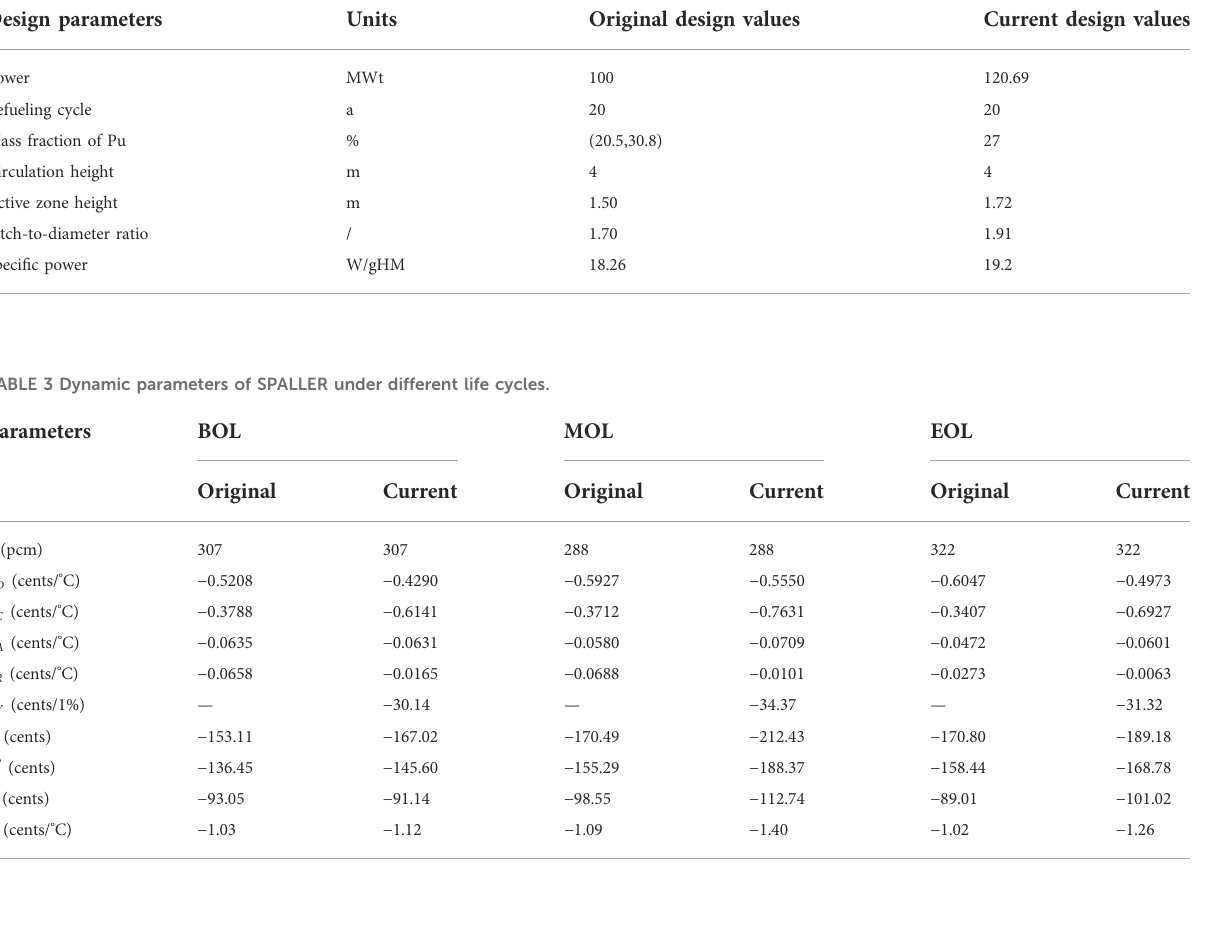
TABLE 4 Accident safety analysis of SPALLER under maximum